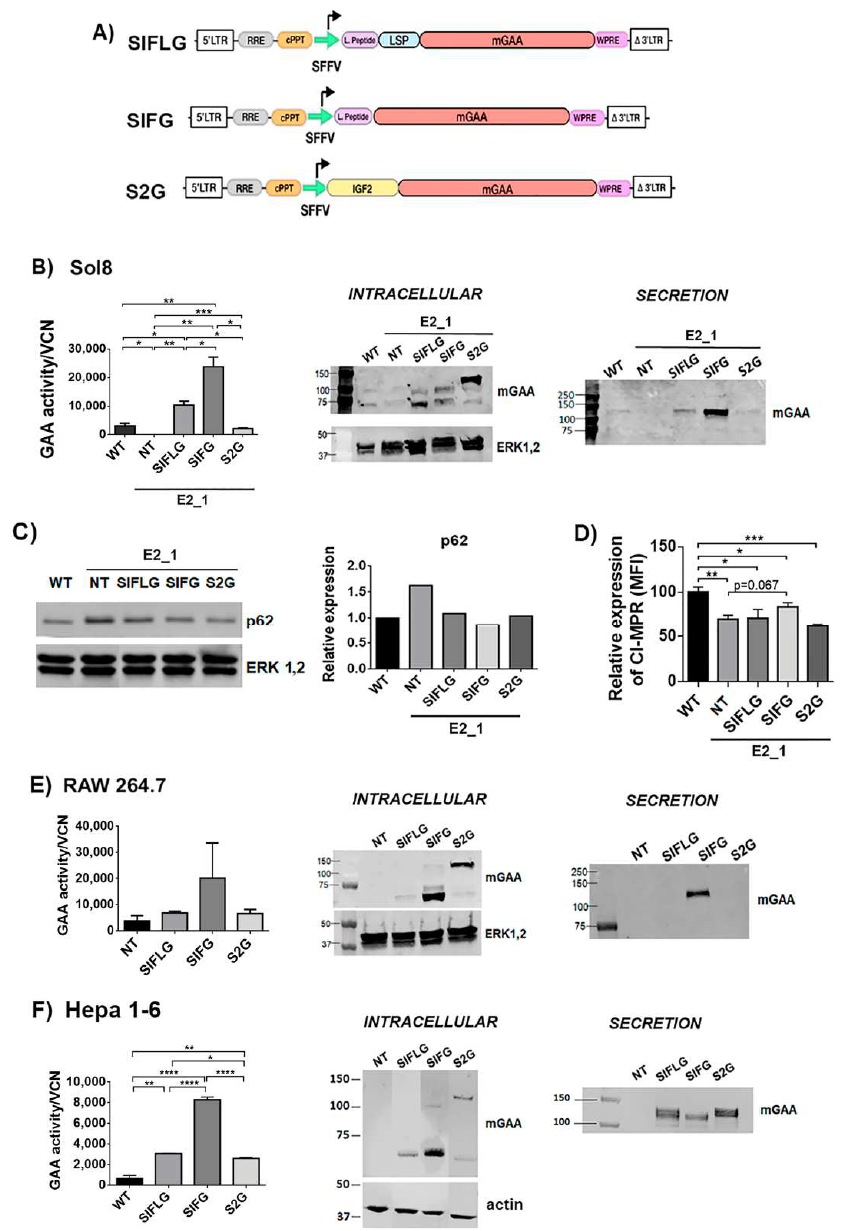
Figure 4. Optimisations of mGAA restore the GAA enzymatic deficit in GAA-KO cells, and it is secreted into the medium. ( A ) Schematic representation of SIFLG, SIFG and S2G constructs. mGAA, murine glucosidase alpha acid; SFFV, spleen focus forming virus promoter; WPRE, woodchuck hepatitis virus post transcriptional regulatory element. ( B ) Analysis of mGAA intracellular activity (left graph) in cell lysates (WT and NT) or after correcting by vector copy number (VCN) (SIFLG, SIFG and S2G). Middle panel and right panels: Western blots of intracellular (middle) or secreted (right) mGAA from Sol8 WT, E2_1 (NT) and E2_1 cells transduced with SIFLG, SIFG and S2G. ( C ) Western blot and quantification of p62 levels relative to ERK1,2 levels in WT, non-transduced E2_1 cells and transduced E2_1 cells with LVs. ( D ) CI-MPRs’ relative expression in rescued Sol8 GAA-KO cells (E2_1). E-F) Analysis of mGAA intracellular activity (left graph) in cell lysates (NT = WT non-transduced) or after correcting by vector copy number (VCN) (SIFLG, SIFG and S2G). Western blot of intracellular mGAA (middle panels) and secreted mGAA (right panels) of ( E ) RAW 264.7 cells and ( F ) Hepa 1-6 cells. Statistical analyses: B , E and F ) unpaired t-test (two tails, * p < 0.05, ** p < 0.01, *** p < 0.001, **** p < 0.0001)). Values represent means +/ − SEM of at least three separate